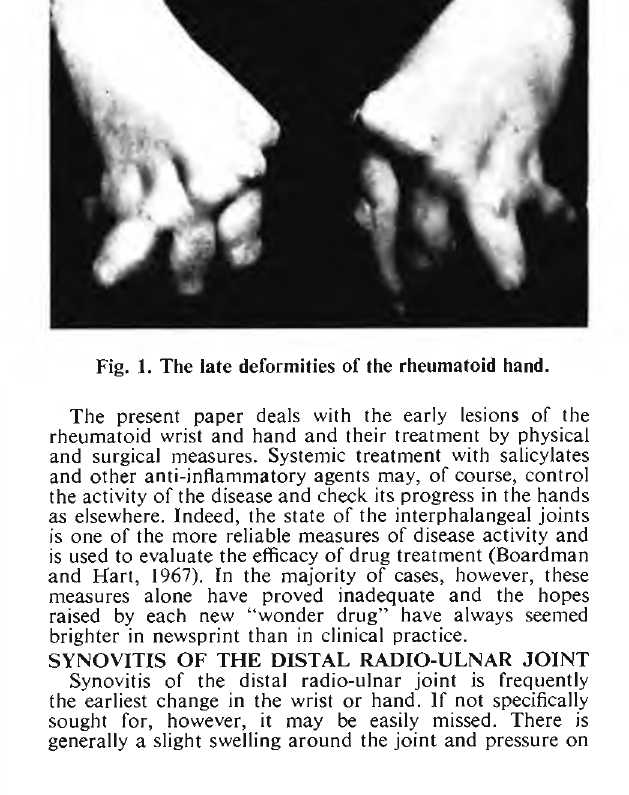
Fig. 1. The late deformities of the rheumatoid hand. Fig. 2. Cystic erosion of the distal end of the ulna associated